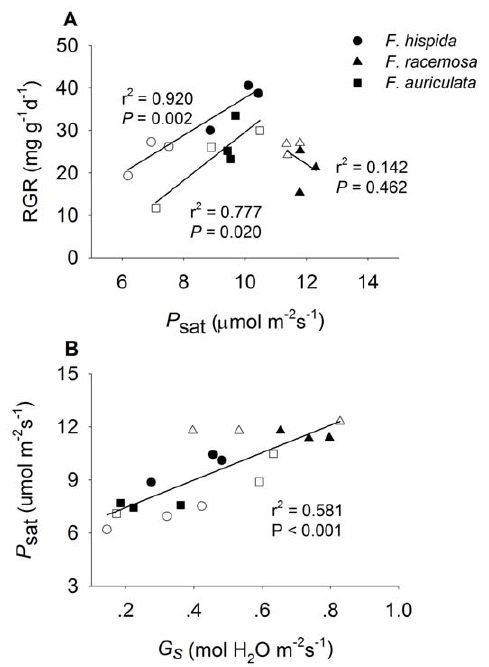
Figure 4. RGR as a function of P sat and P sat as a function of G s in Ficus saplings under two soil nutrient levels. Significant differ- ences between treatments are marked with different letters (mean 6 SE, n=3, P , 0.05). Black shapes, fertile, white shapes, infertile. RGR relative growth rate (mg ? g 2 1 ? d 2 1 ); P sat , light saturated photosynthetic rate ( m mol m 2 2 s 2 1 ); G s , stomatal conductance (mol H 2 O m 2 2 s 2 1 ).